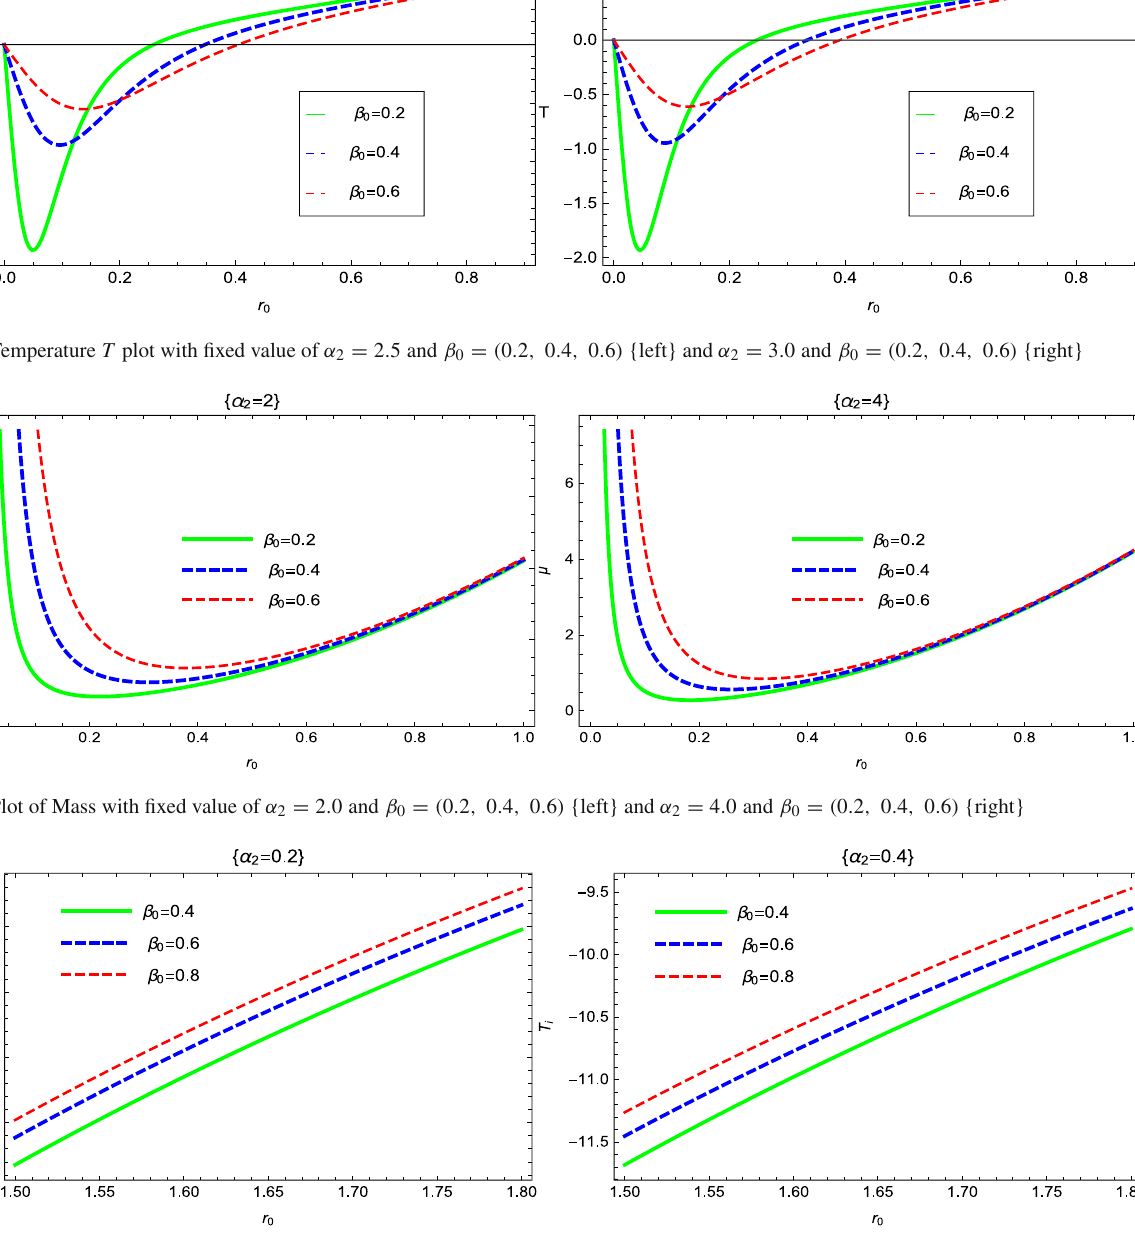
Fig. 9 Plot of of inversion temperature with fixed of α 2 = 2 and β 0 = ( 0 . 4 , 0 . 6 , 0 . 8 ) {left} and α 2 = 4 . 0 and β 0 = ( 0 . 4 , 0 . 6 , 0 . 8 )